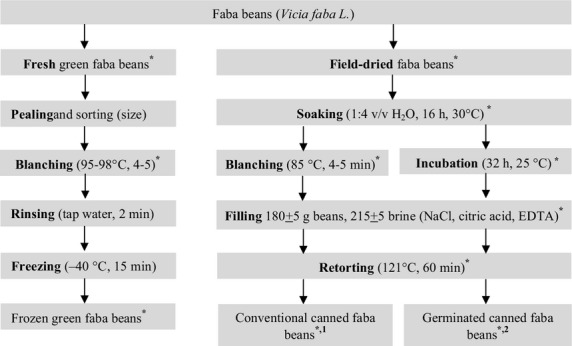
Industrial processing of green and field-dried faba beans. *Sampling points: tins of canned faba beans were opened and drained; subsamples of the drained beans and the canning medium were stored separately. 1The weight of drained beans was 290 ± 5 g and that of canning medium 100 ± 5 g. 2The weight of drained beans was 260 ± 5 g and that of the canning medium 130 ± 5 g. Samples (150 g of drained faba and 100 g of canning medium) were vacuum-packed in polyethylene bags and were transported under cooling to the Food Industries Department, Mansoura University, Mansoura, Egypt. Immediately upon arrival, samples were stored at −20°C and folate quantification was performed within 1 month.